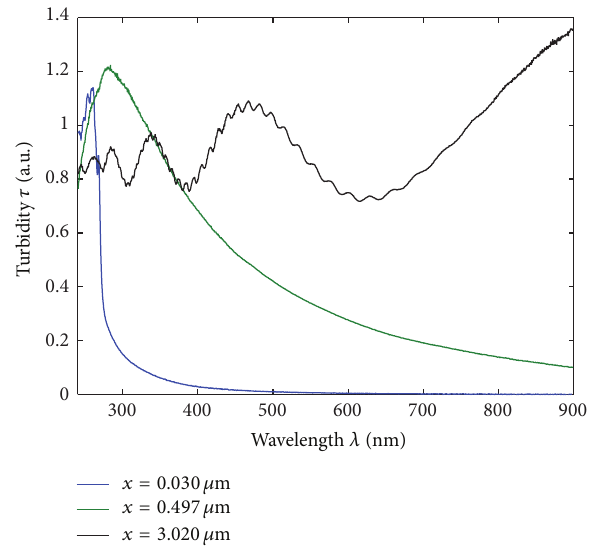
Figure 2: Measured turbidimetric spectra of the polystyrene latex suspensions.